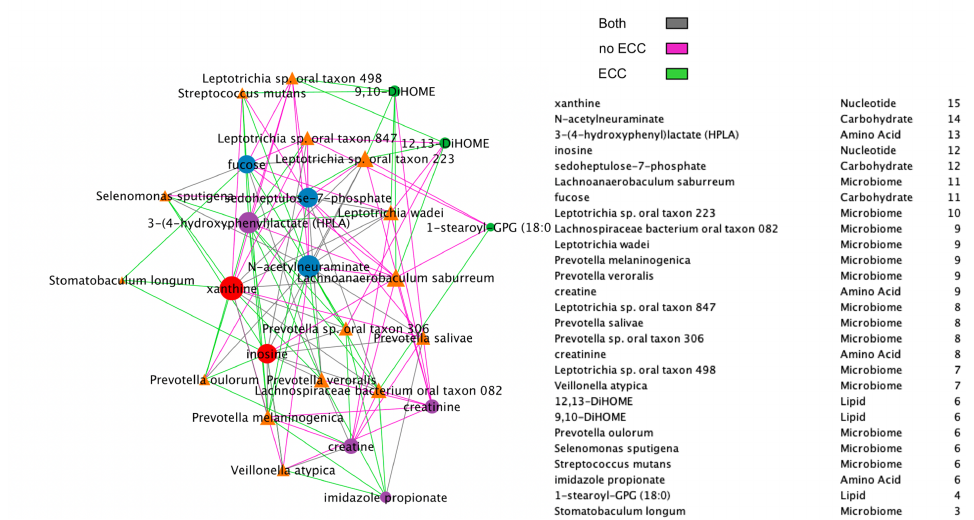
Figure 7. BZINB network between species and metabolites including a node degree table. The strongest 30% of correlations are presented in the diagrams, and line colors represent whether the correlation was strong in one or both of the healthy/disease groups.